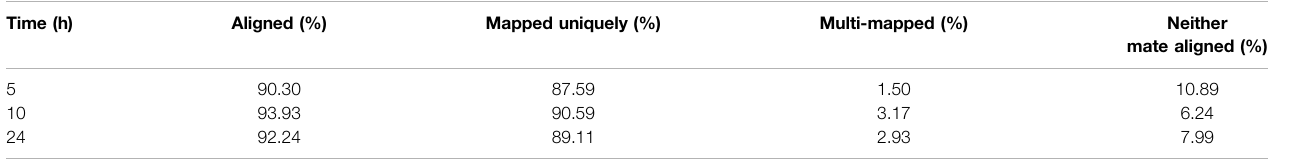
TABLE 1 | Alignment statistics of the clean